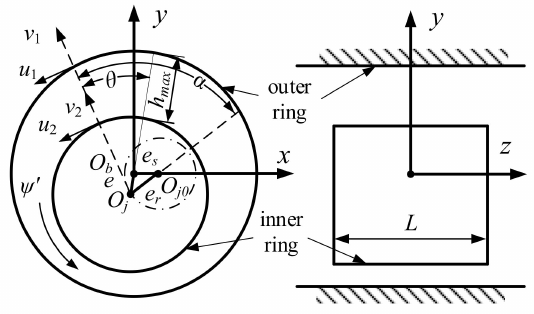
Figure A3. Calculation model of static eccentric